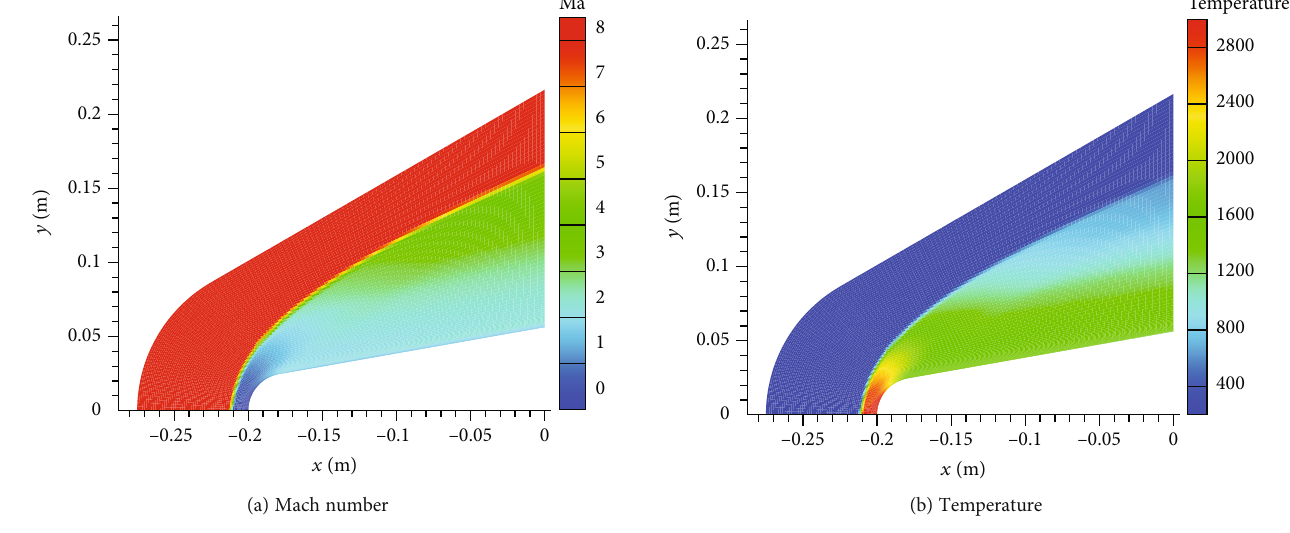
Figure 12: Distribution of fl ow fi eld at 20 s.